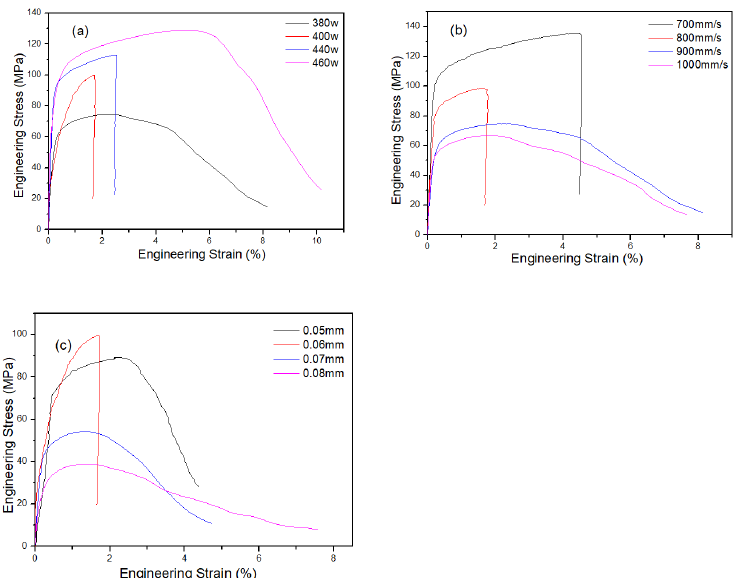
Figure 9. Stress–strain curves variation of the as-built samples with ( a ) laser power, ( b ) scanning speed and ( c ) hatching distance (in this case, ( a ) scanning speed of 900 mm/s, hatching distance of 0.06 mm; ( b ) laser power 380 W, hatching distance 0.06 mm and ( c ) laser power 400 W, scanning speed 900 mm/s).